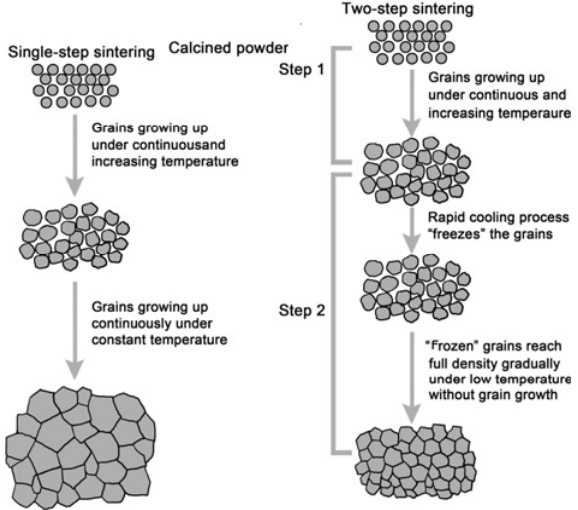
Fig. 18 Different mechanisms of grain growth in one-step sintering process and two-step sintering process. Reproduced with permission from Ref. [74], © Elsevier B.V. 2013.